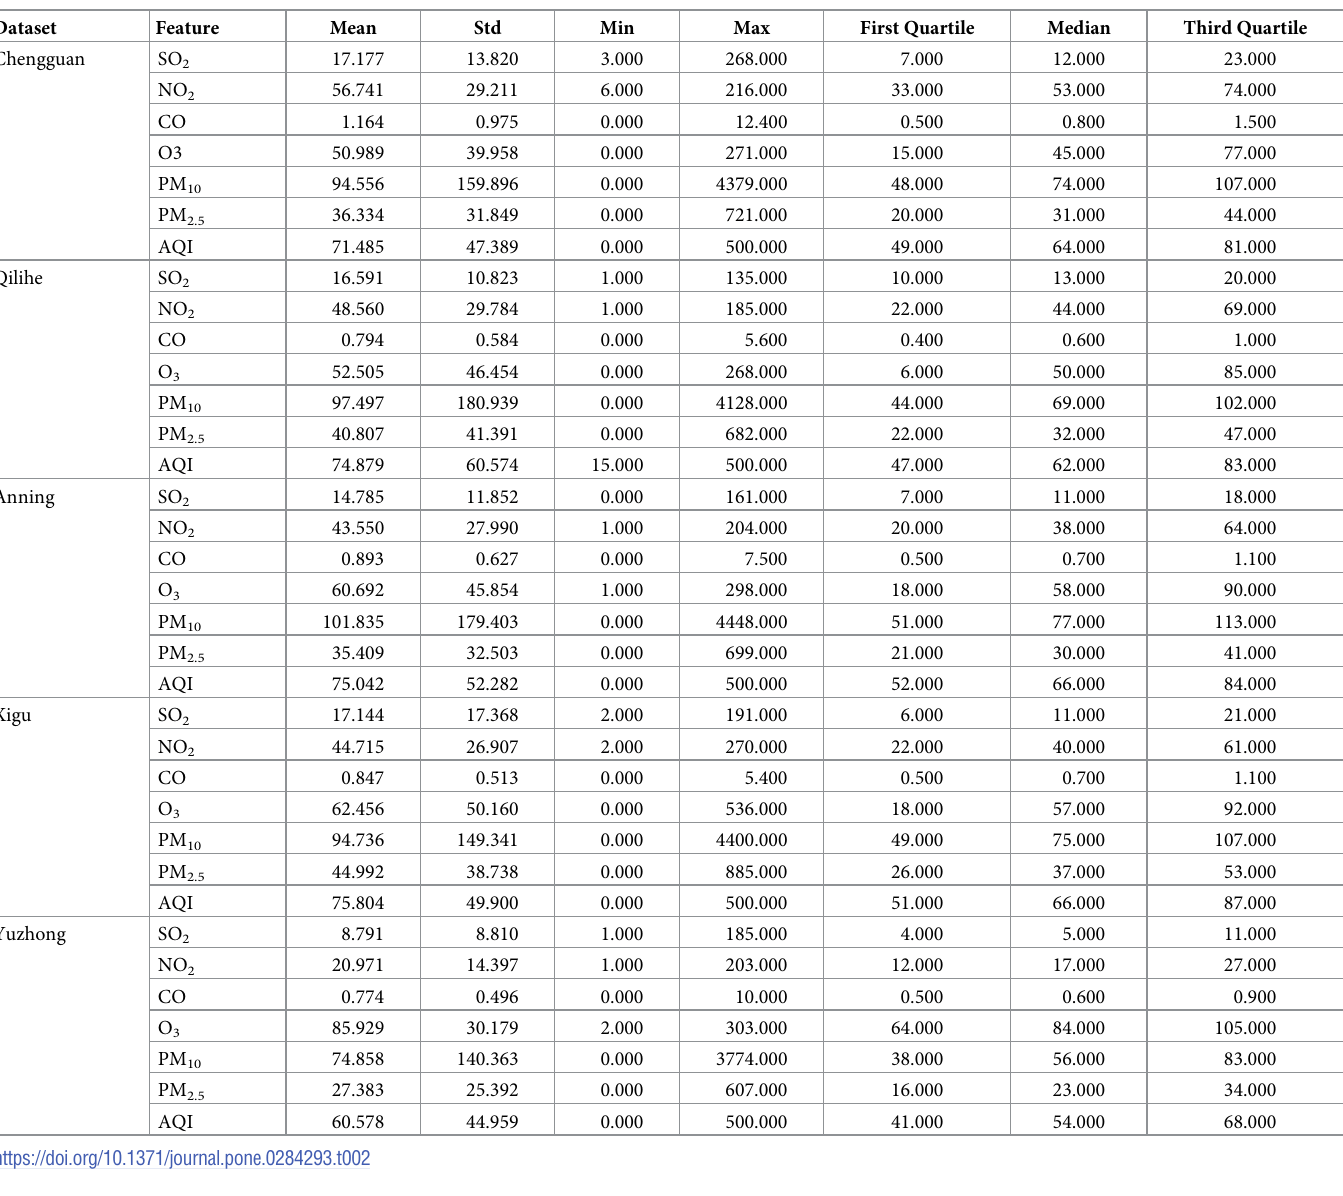
Table 2. The basic statistical characteristics of five